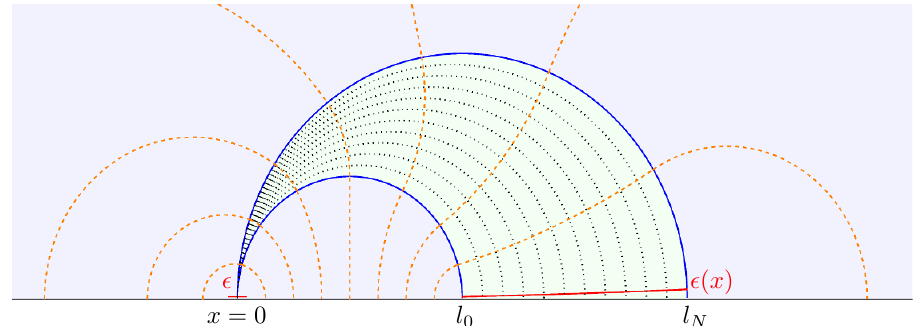
Figure 5 . An explicit construction of a maximally packed (cid:13)ow. In this example we have considered a family of intervals A n with left boundary located at x L = 0 and right boundary at x R = l n , with l n +1 > l n . The two limiting minimal surfaces m ( A 0 ) and m ( A N ) bound the portion of the bulk that is shaded in green. In this region, the vector V has maximal norm, i.e., j V j = 1 and is orthogonal to the intermediate minimal surfaces m ( A n ). The UV cuto(cid:11) that leaves the (cid:13)ux across the di(cid:11)erent surfaces constant is shown in red, but other choices are also allowed. The regions inside of m ( A 0 ) and outside of m ( A N ), which are shaded in blue, are continued with the geodesic (cid:13)ows constructed with the algorithm of section